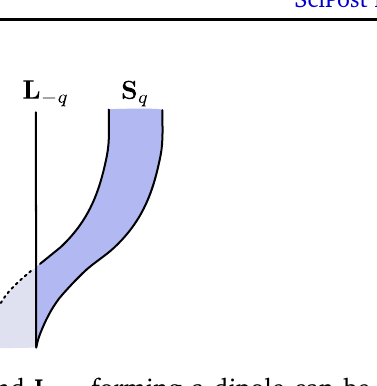
Figure 1: Two charge defects, L and L − , forming a dipole can be deformed to a q q strip operator, S as long as that deformation is orthogonal to the dipole q